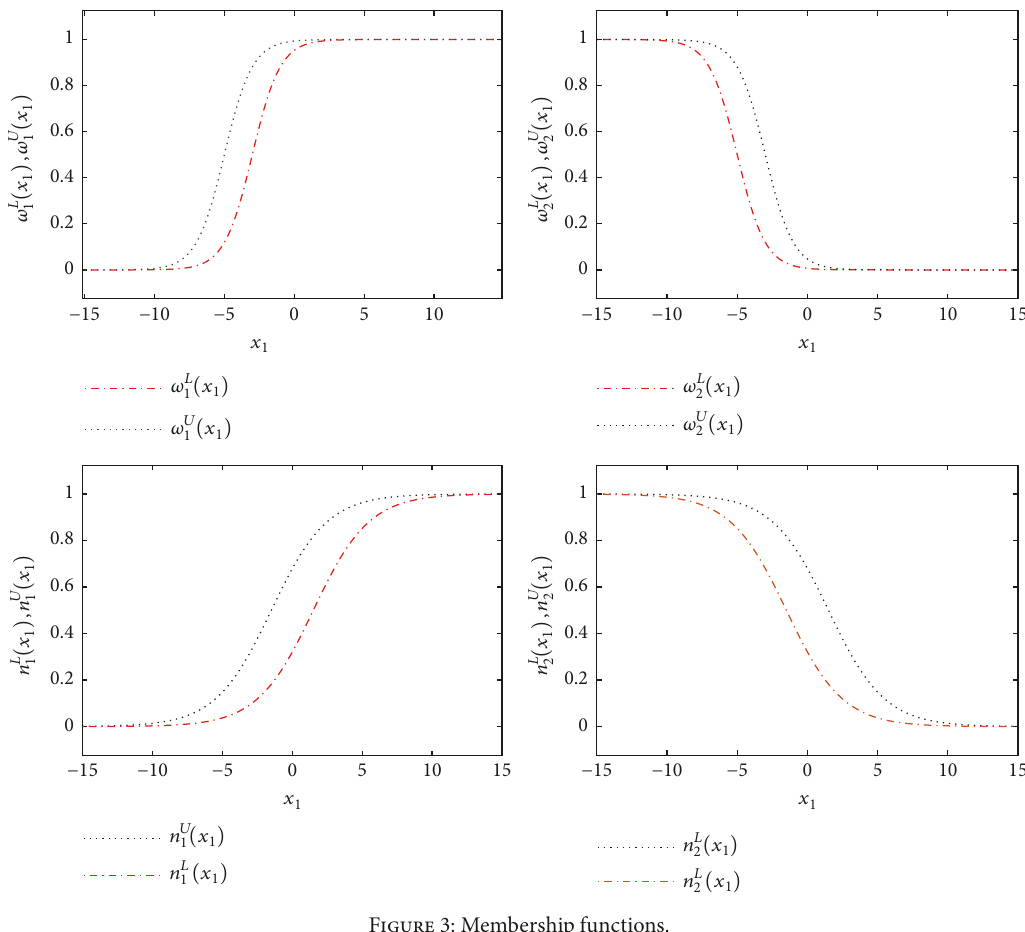
Figure 3: Membership